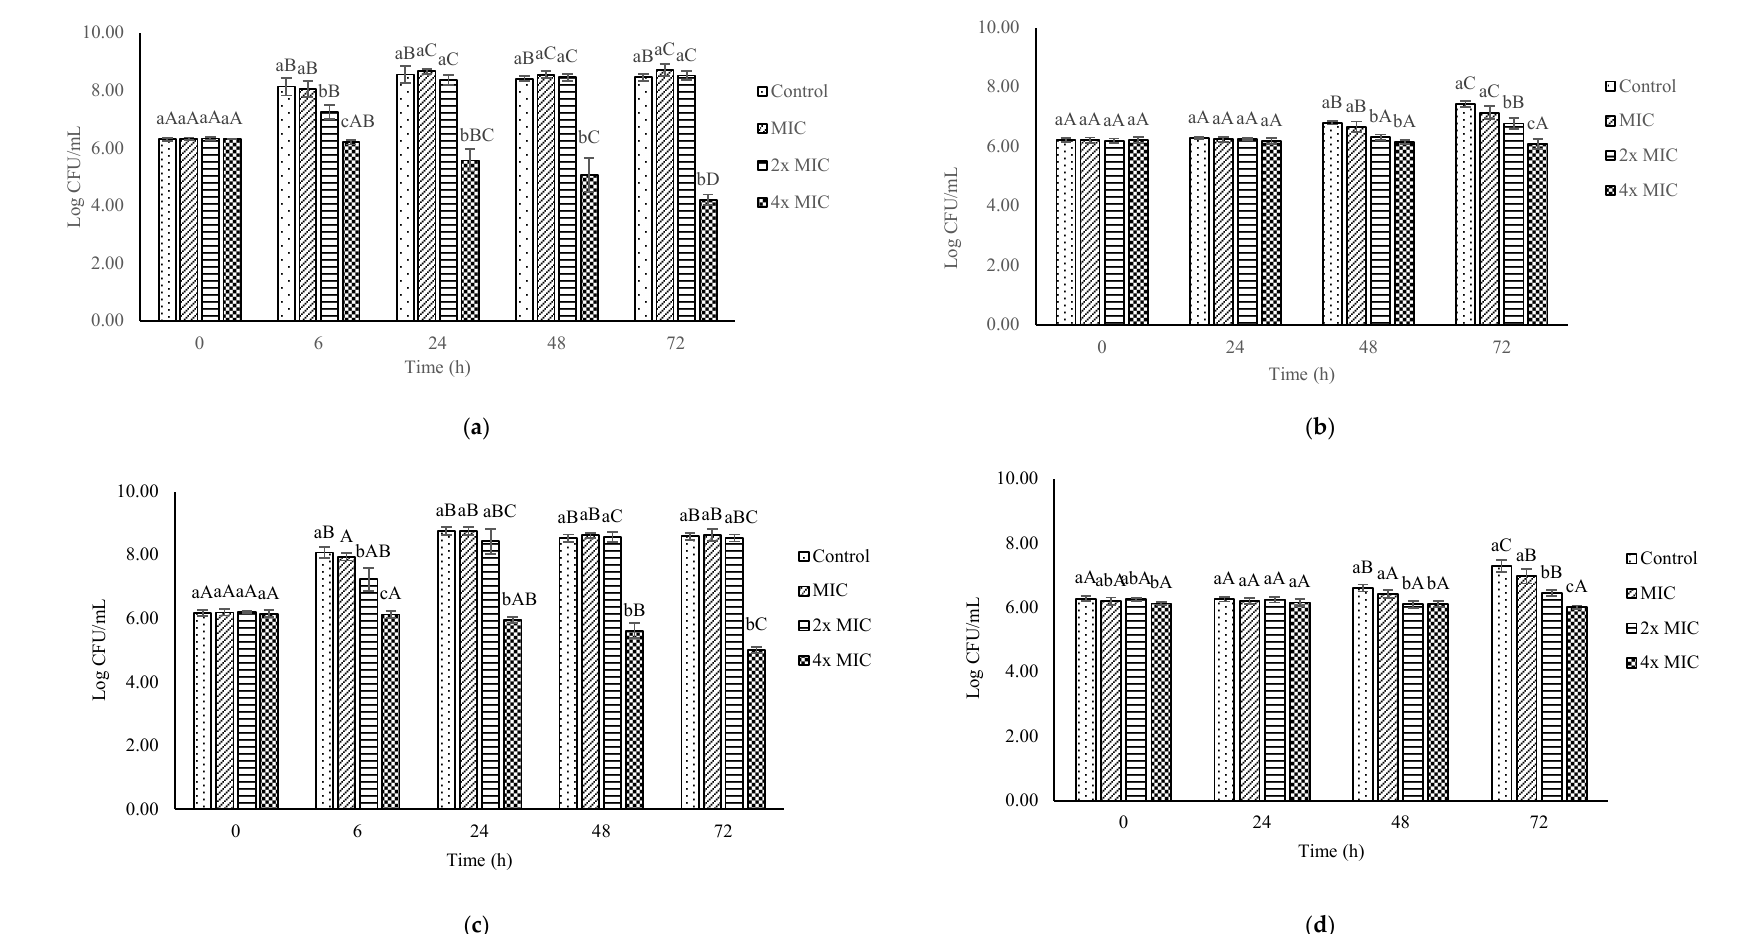
Figure 4. Effect of ohelo berry juice at concentrations of 12.5% (MIC), 25% (2× MIC), and 50% (4× MIC) on the growth of L. monocytogenes in whole milk at 37 °C ( a ), whole milk at 7 °C ( b ), skim milk at 37 °C ( c ), and skim milk at 7 °C ( d ) for 72 h. Within each time point, means with different lowercase letters are significantly different ( p < 0.05) between the treatments. Within each treatment, means with different capital letters are significantly different ( p < 0.05) between the time points .